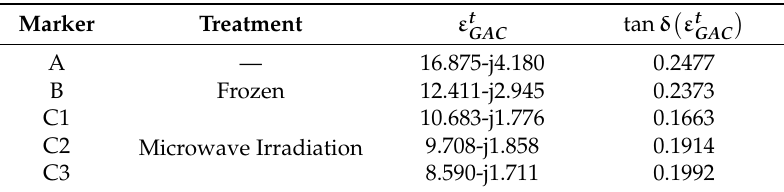
Table 3. The complex permittivity of the ideal perfect GAC in Model